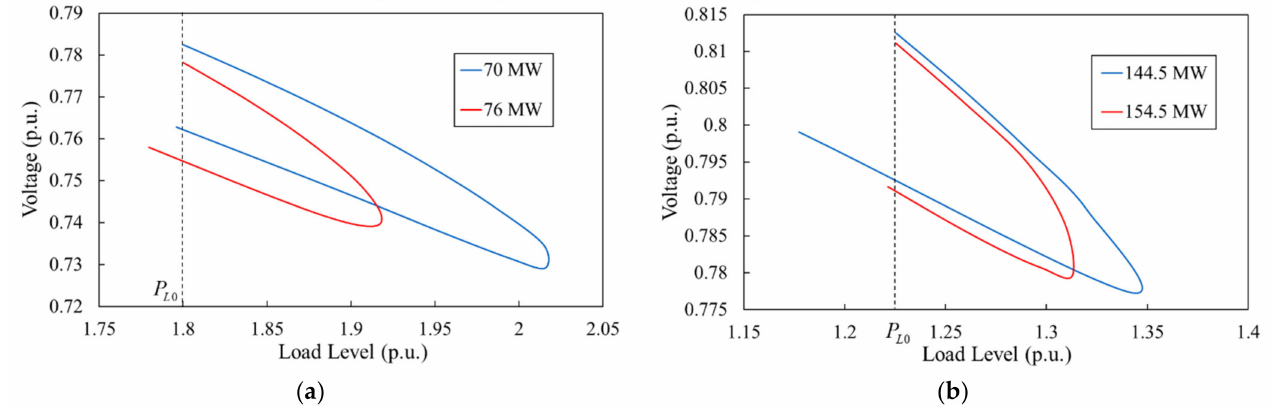
Figure 7. PV curves after the wind power integration in the local power grids A and B; ( a ) PV curves at the node KL in the local power grid A; ( b ) PV curves at the node LH in the local power grid